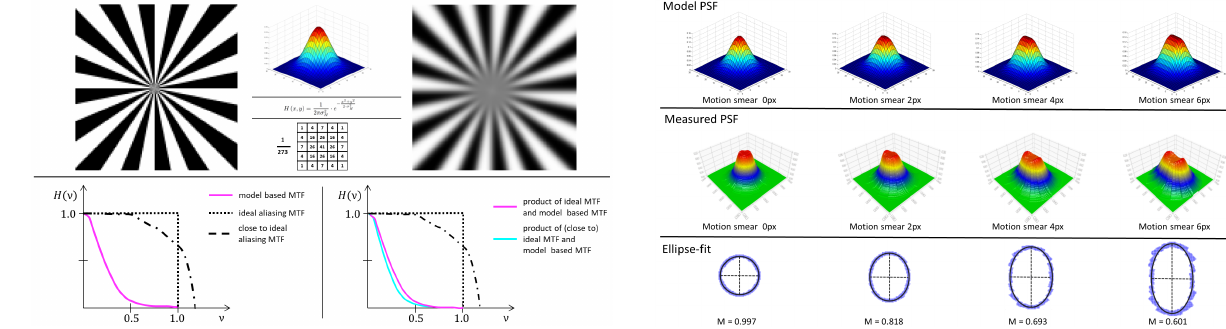
Figure 5. Original image (upper left) continuous and discrete Figure 6. (top) Model convolution-kernel with rising influence Gaussian PSF convolution kernel (upper mid) and convolution of motion from 0 to 6 pixel, (middle) measured PSF of images result (upper right), ideal aliasing MTF, close to ideal aliasing convoluted with model-kernels, (bottom) corresponding ellipse MTF and model-based MTF (lower left), related products in fit for 2D-MTF10 and relation M of semi-minor ellipse-axis e s frequency domain (lower right) and semi-major ellipse-axis e to as resolution limit or cut-off frequency of MTF ˜ H ( k ) = 0 . 10